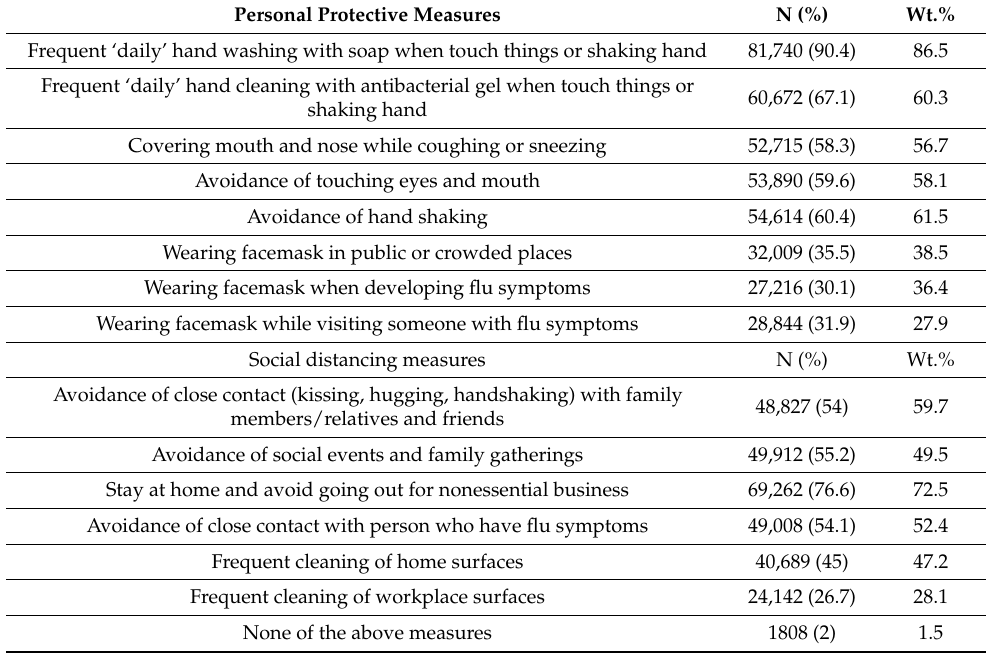
Table 7. Personal protective measures compliance among public.